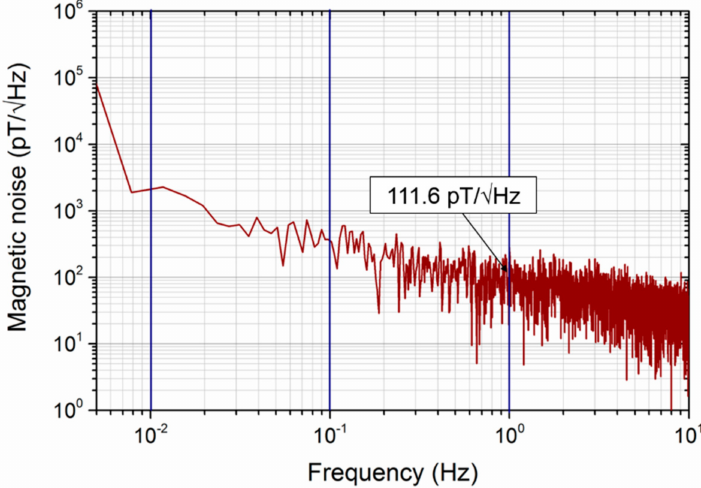
Figure 7. The magnetic noise spectrum of an eight-strip meander-core orthogonal fluxgate sensor working in fundamental